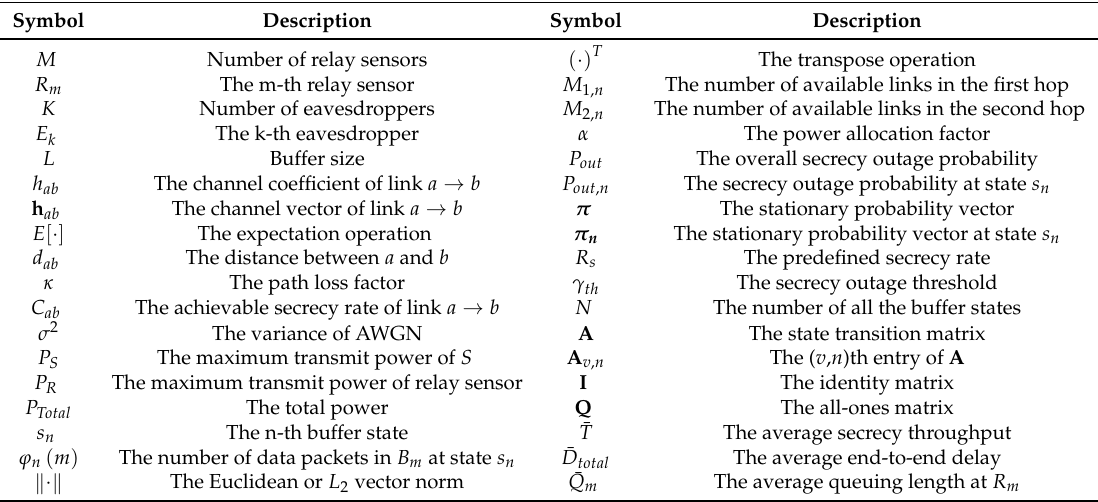
Table 1. List of the main notations and